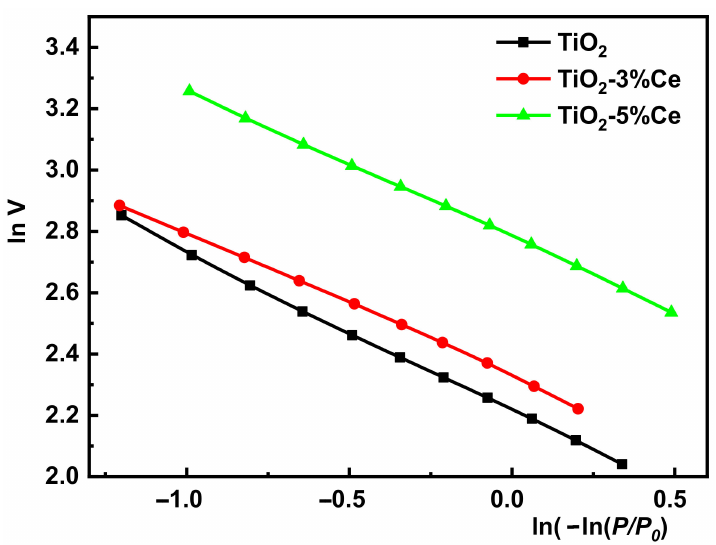
Figure 4. Dependence of ln V on ln( − ln P / P 0 ) for the fibrous TiO 2 and TiO 2 –xCe samples. Thus, the texture of the photocatalysts explains the increasing adsorption of rhodamine B along the series TiO 2 < TiO 2 –3% Ce < TiO 2 –5% Ce. The UV–Vis absorption spectra of the samples are shown in Figure 5. The TiO 2 –3% Ce and TiO 2 –5% Ce samples showed a stronger (up to 10%) blue/UV light absorption than pure TiO 2 . It is evident that a higher UV light absorption by the Ce-doped systems intensifies the formation of electron–hole pairs during the photocatalysis [32] and partly explains why the catalytic properties of the Ti–Ce oxide samples were better than those of pure TiO 2 . Ce 4+ compounds are often yellow, which agrees with the higher absorption from 400–470 nm. Ce 3+ compounds showed a strong 4f-5d absorption in the UV. Both facts indicate a stronger absorption of the Ti–Ce oxides compared to Ti oxide.